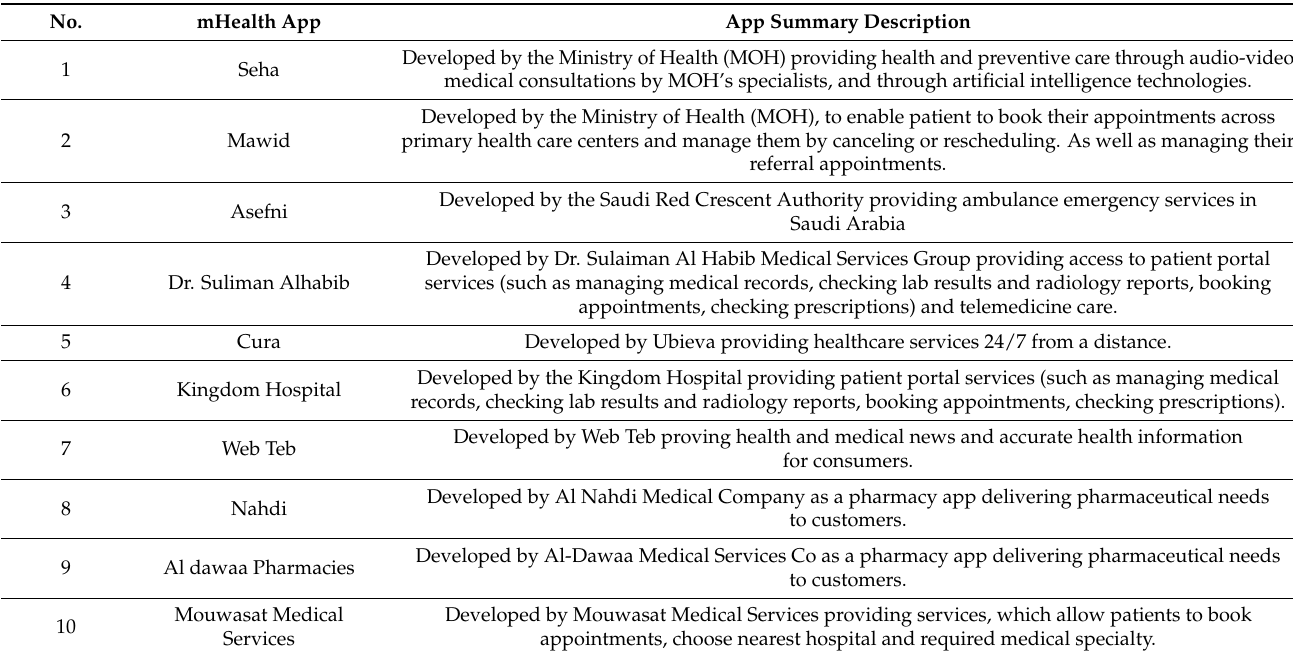
Table A1. List of mHealth apps published by NDT [29] in 2020 during the time of our study *.